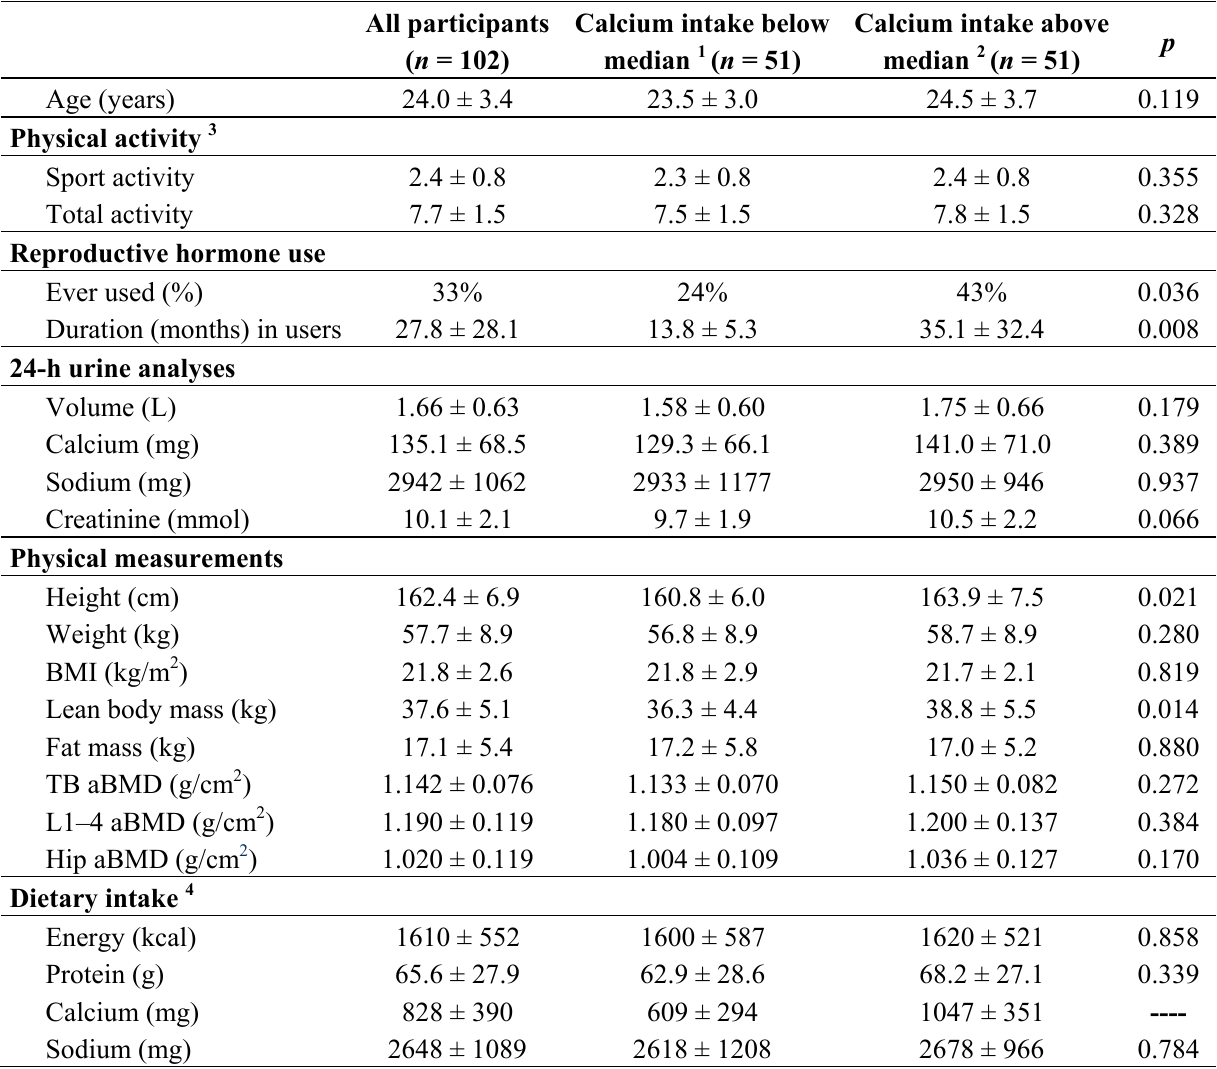
Table 1. Age, physical activity, reproductive hormone use, 24-h urine analyses, physical measurements and dietary intake among all participants and differences by calcium intake (median